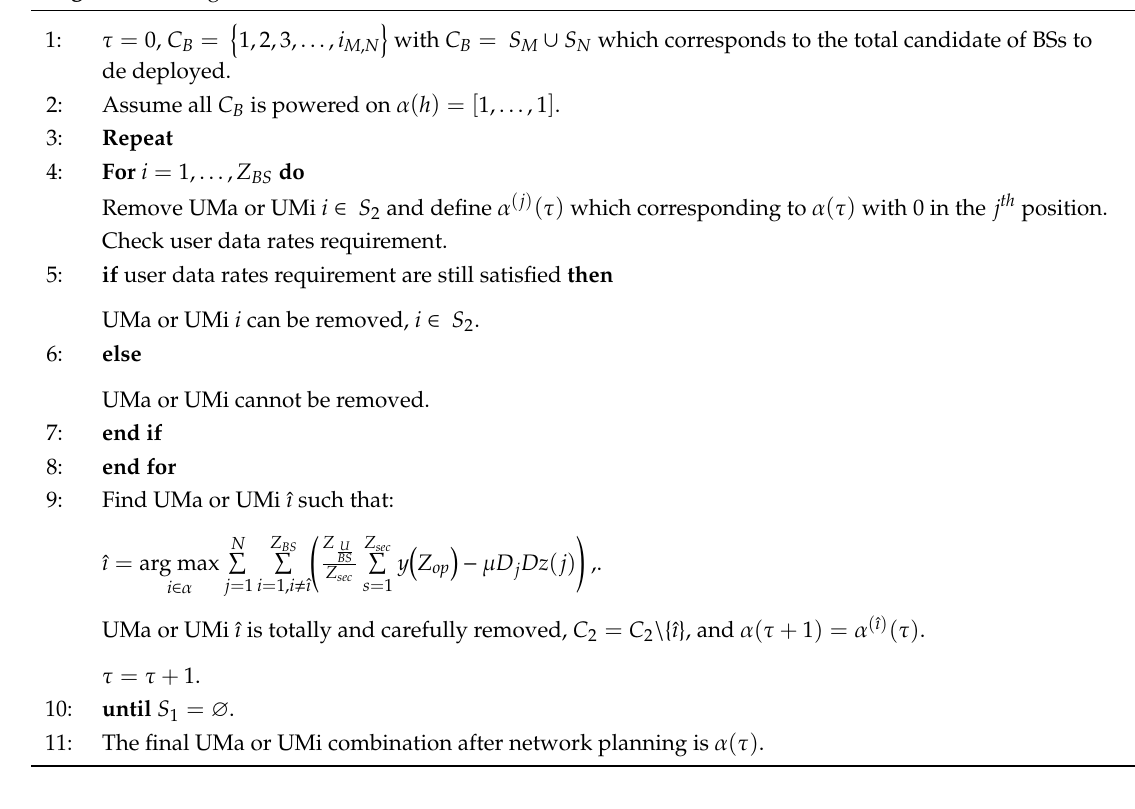
Algorithm 2: Algorithm for redundant UMa and UMi